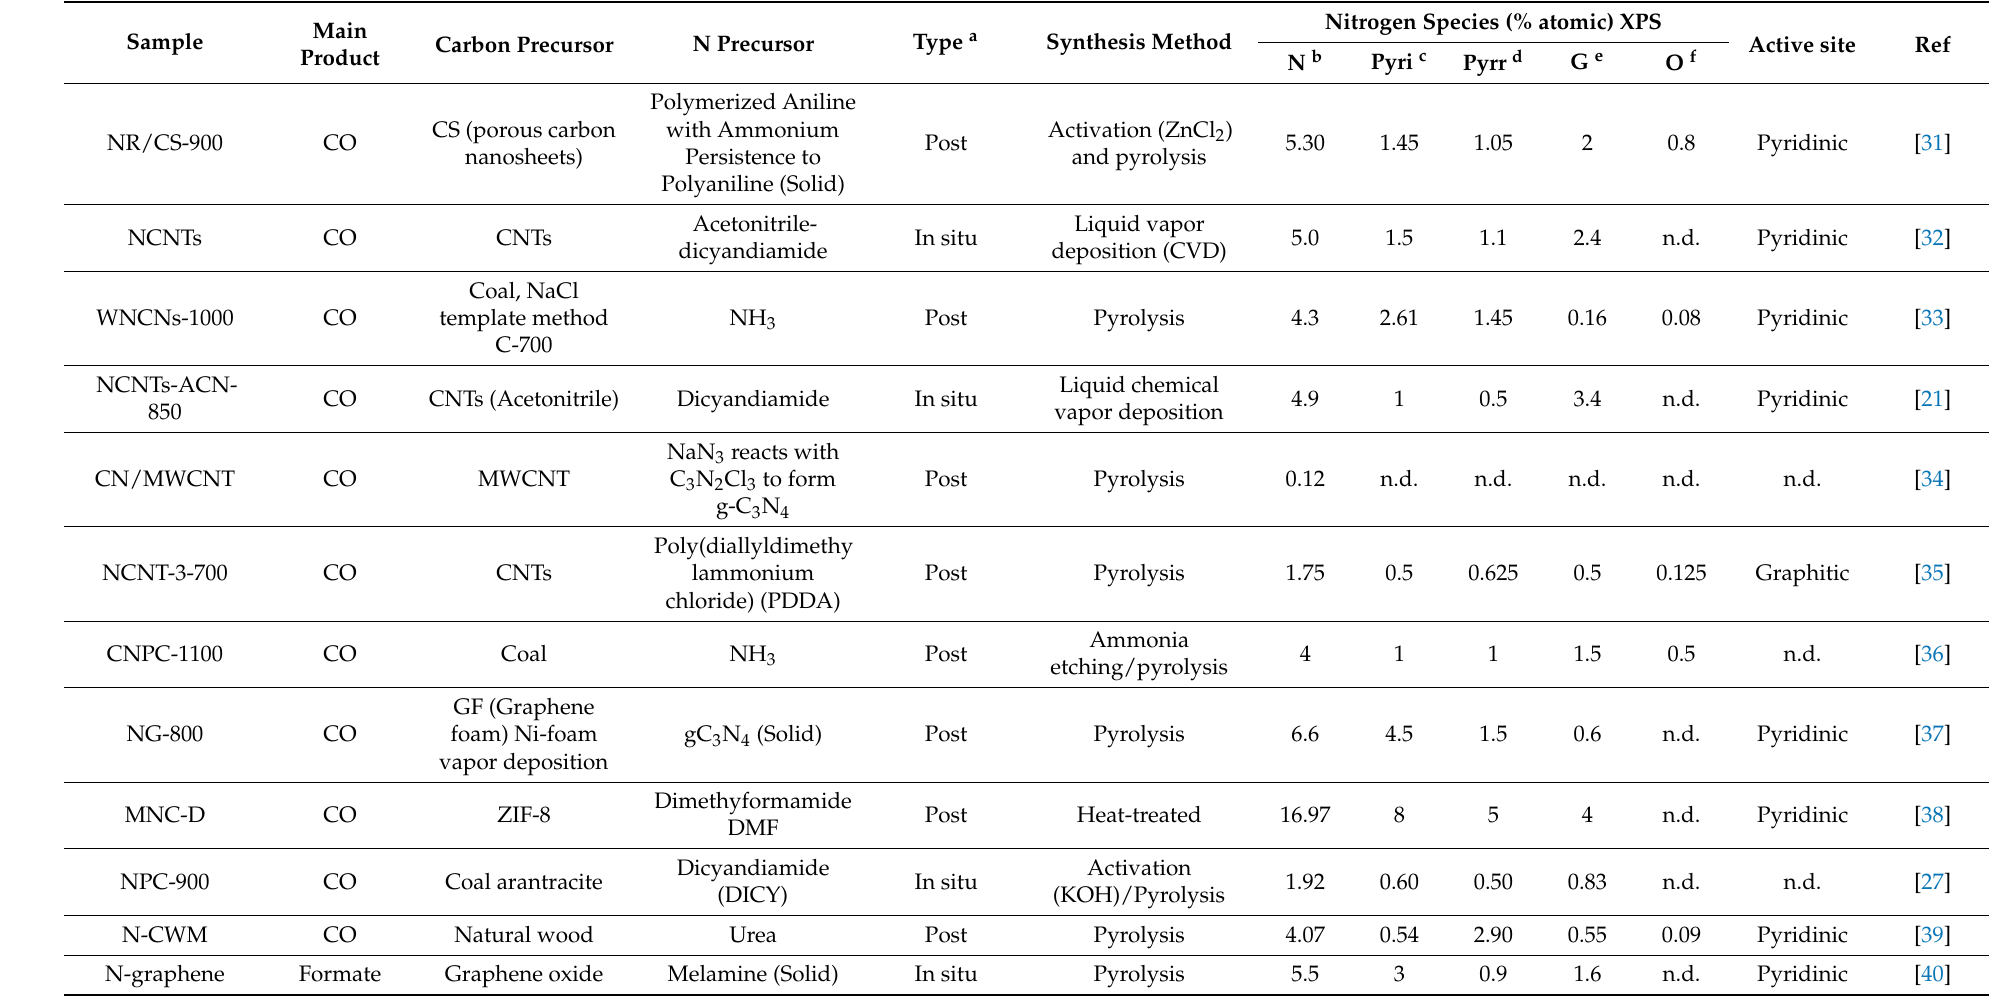
Table 2. Carbon and nitrogen precursors to construction of electrocatalysts and active